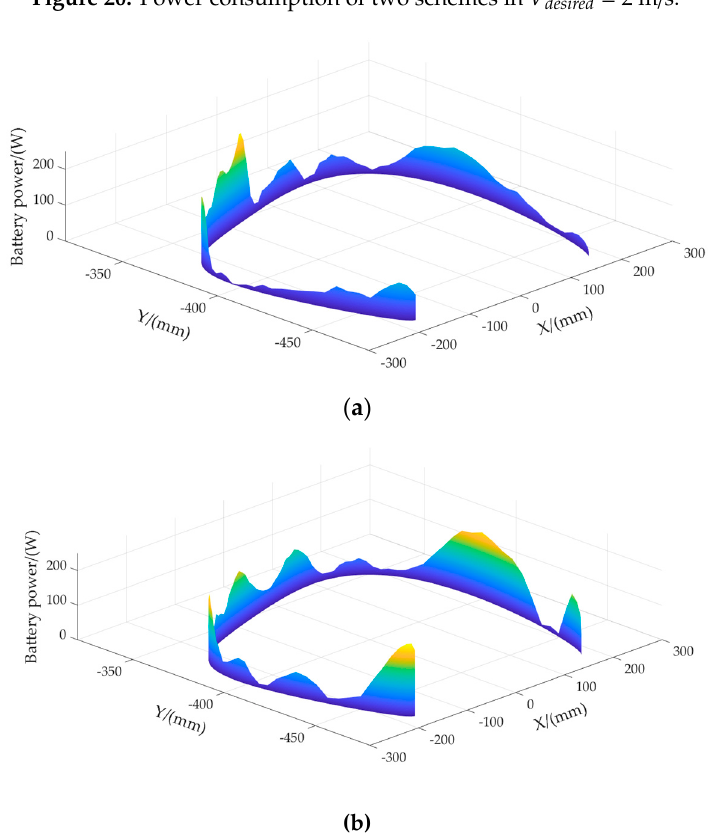
Figure 21. Time traces of the energetics of legs swing with two schemes. ( a ) The battery power consumption of the scheme I with spline curve in swing phase. ( b ) The battery power consumption of the scheme 2 with Bézier curve in swing phase.